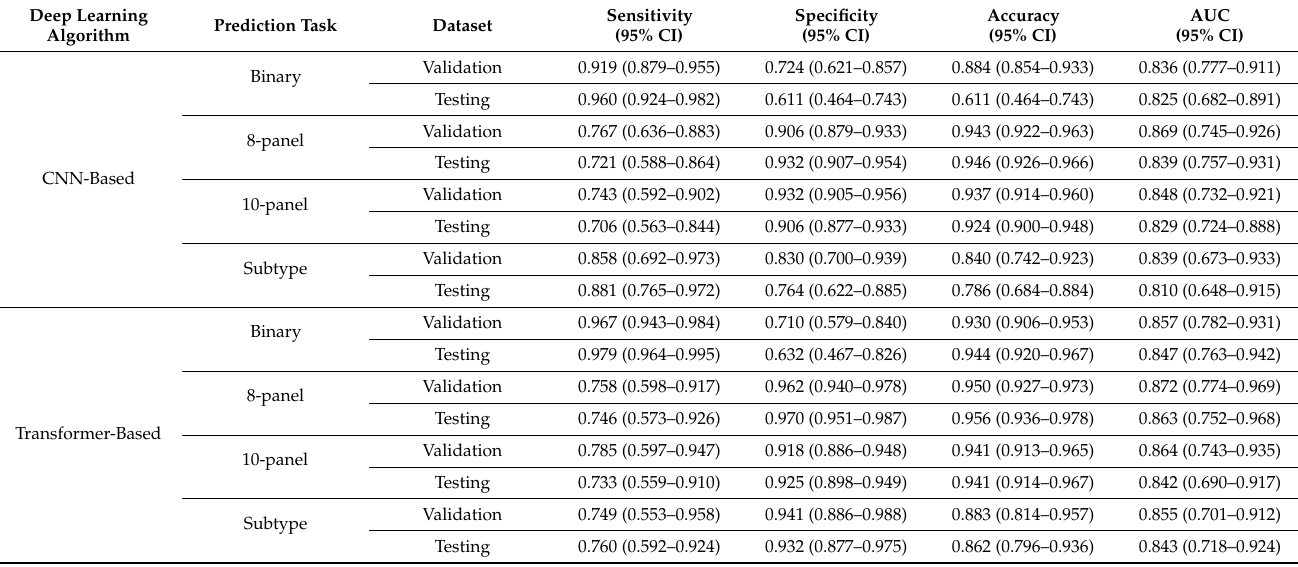
Table 2. Predictive performance of deep learning